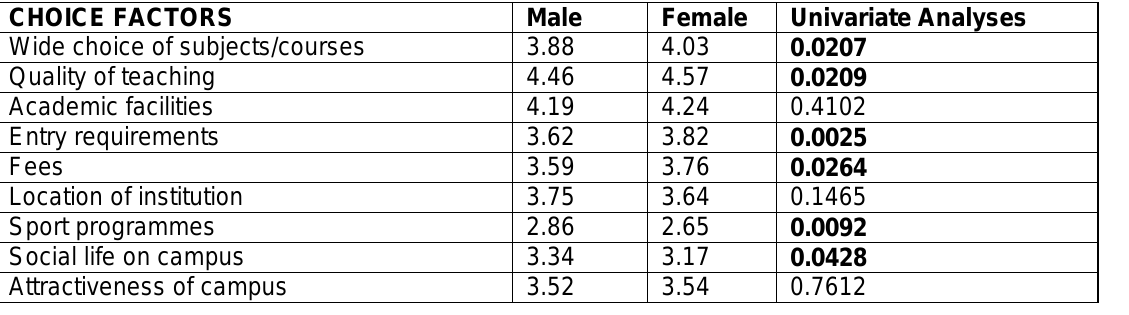
Table 2: Mean values and MANOVA results for different gender groups CHOICE